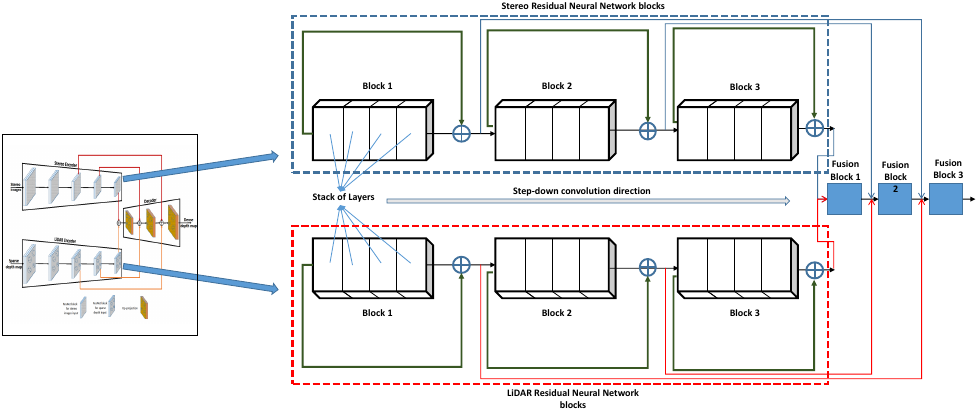
Figure 3. SLS–Fusion encoder–decoder architecture: The residual neural network blocks (ResNet blocks) within the encoder are used to extract features from the LiDAR and stereo inputs. The fusion process inside the decoder is accomplished through the use of addition and up-projection operators.